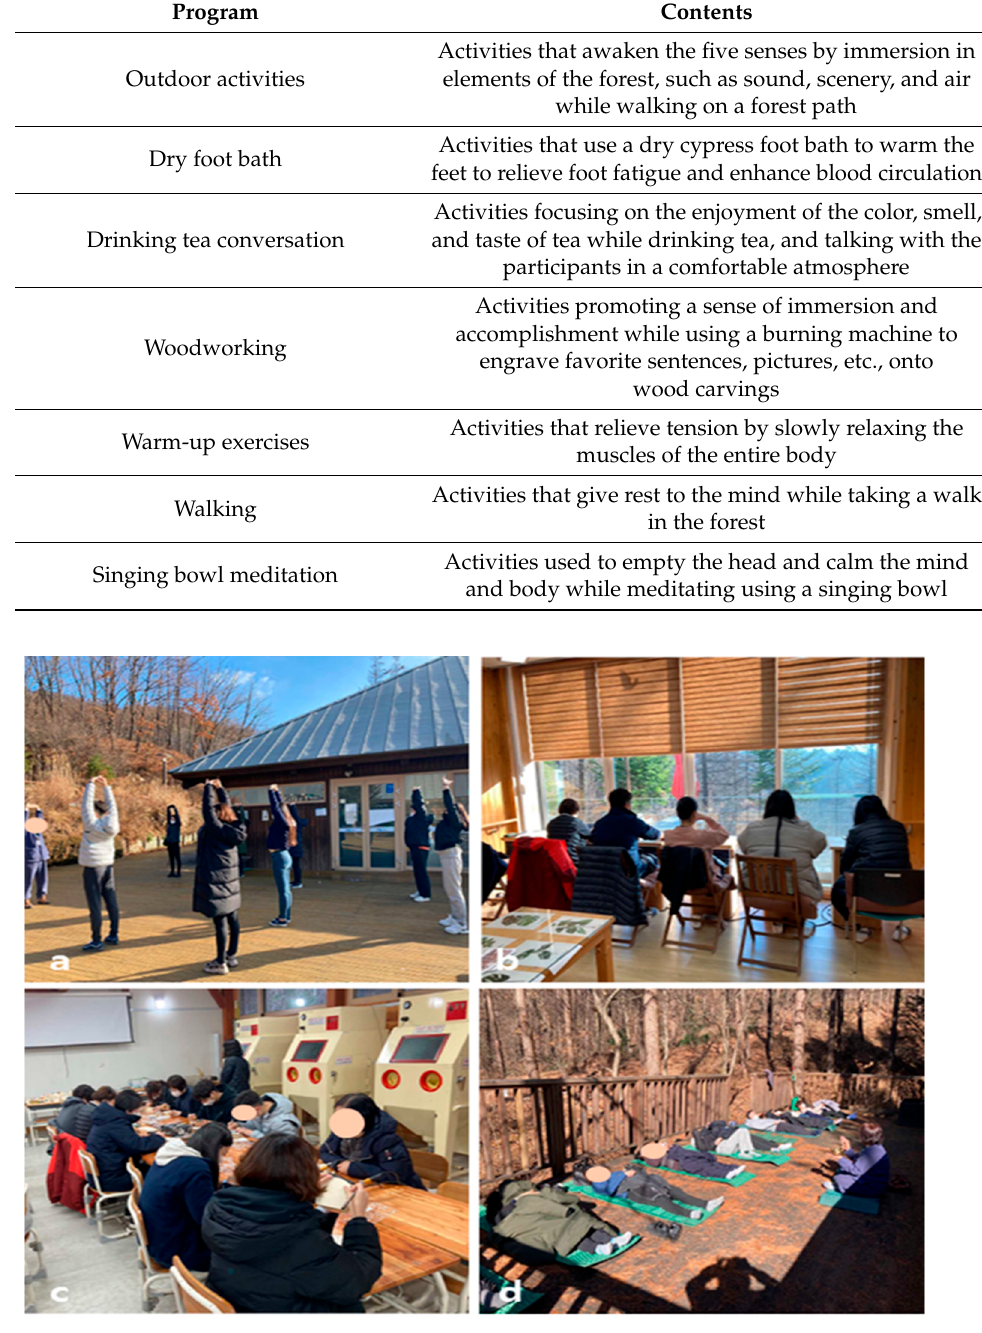
Figure 1. Participants performing activities such as: ( a ) warm-up exercises early in the morning, ( b ) light exposure with tea time at 11:00 am, ( c ) making crafts with wood, and ( d ) singing bowl meditation in the evening. meditation in the